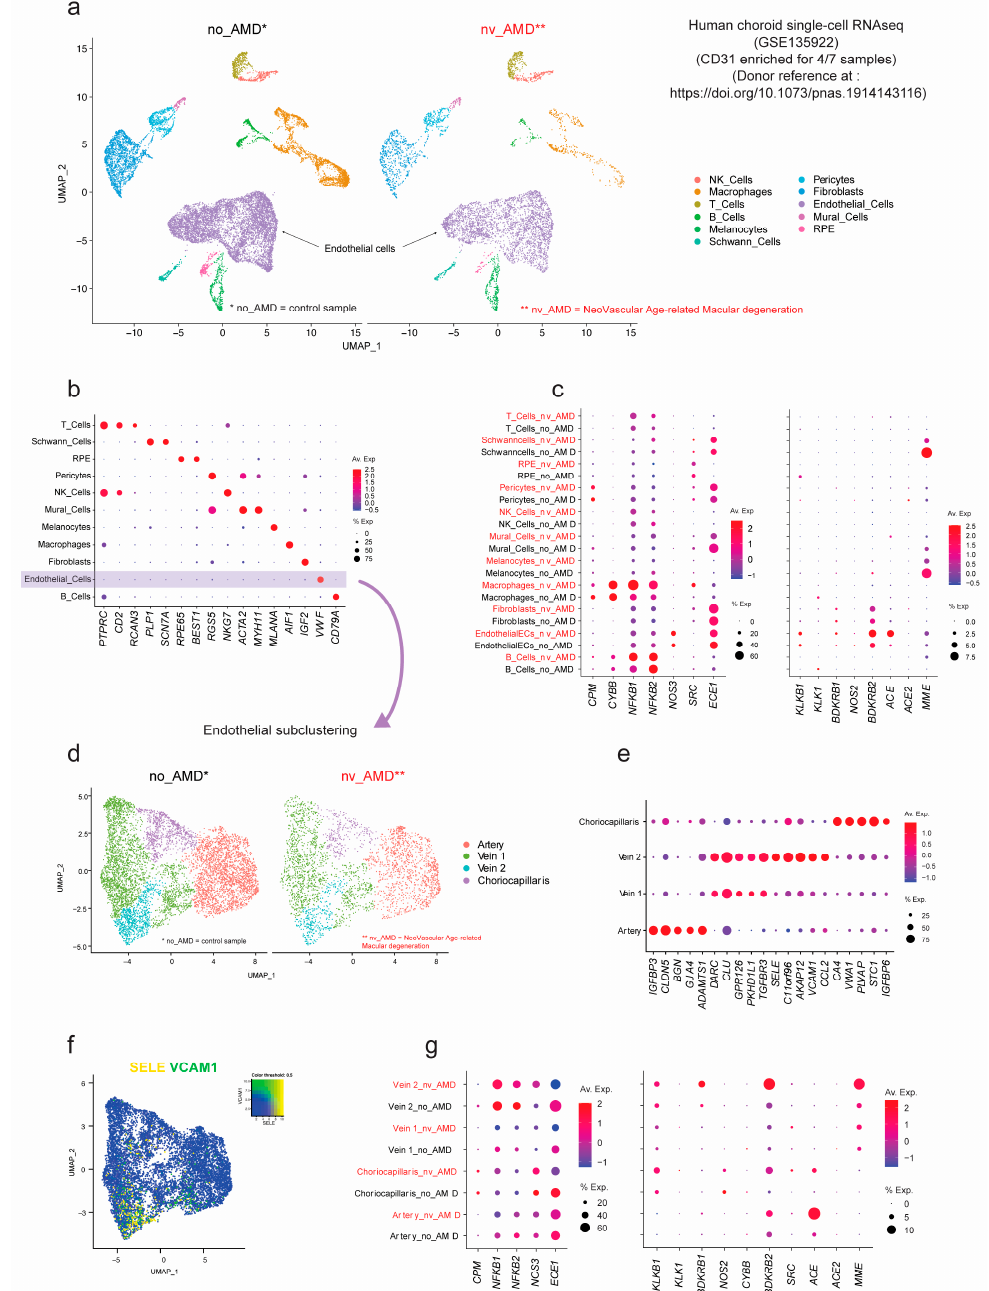
Figure 3. Transcriptomic impact of age-related macular degeneration on the kallikrein-kinin